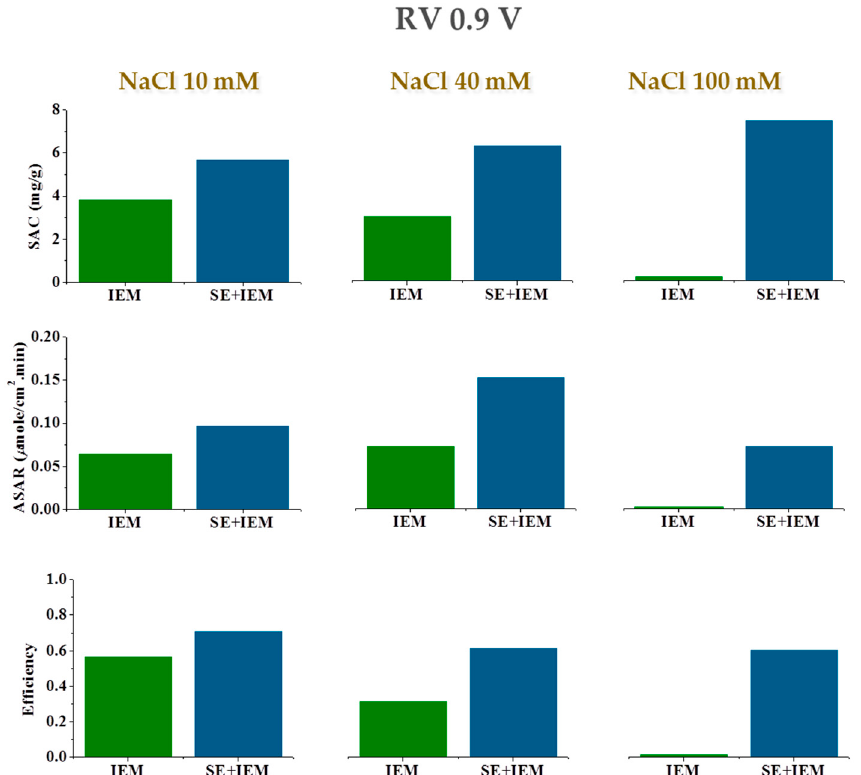
Figure 7. Salt adsorption capacity ( SAC ), adsorption rate ( ASAR ), and charge efficiency comparison between the use of membranes alone (MCDI) and the combination with polyelectrolyte coating (SE + MCDI).